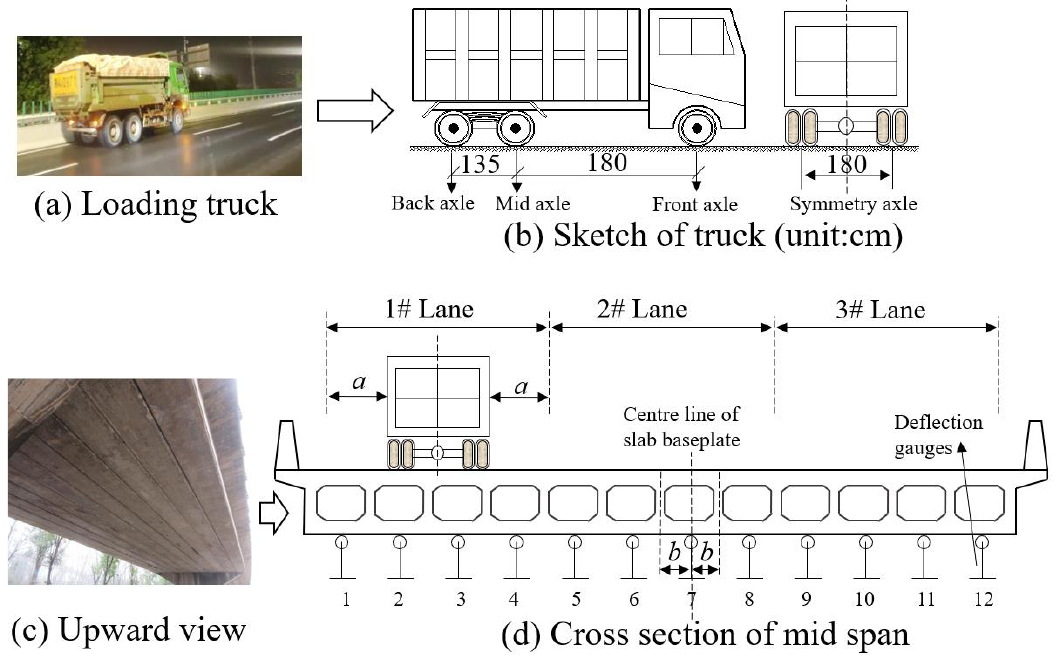
Figure 2. Schematic diagram of the test conditions for the light-load field test.